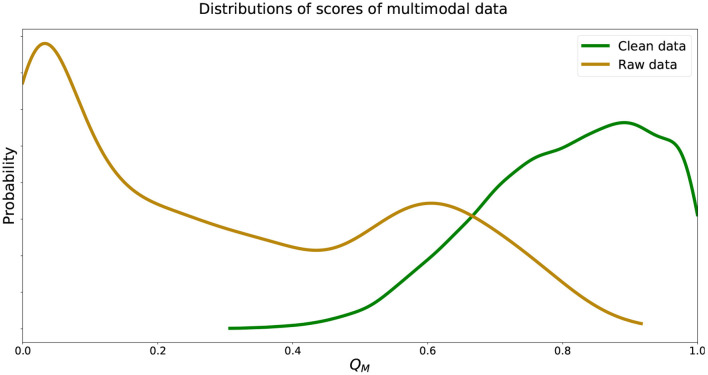
Estimated distributions of QM for CMotion,model and RMotion,model. Distributions of QM of CMotion,model and RMotion,model intersect at QM = 0.62.